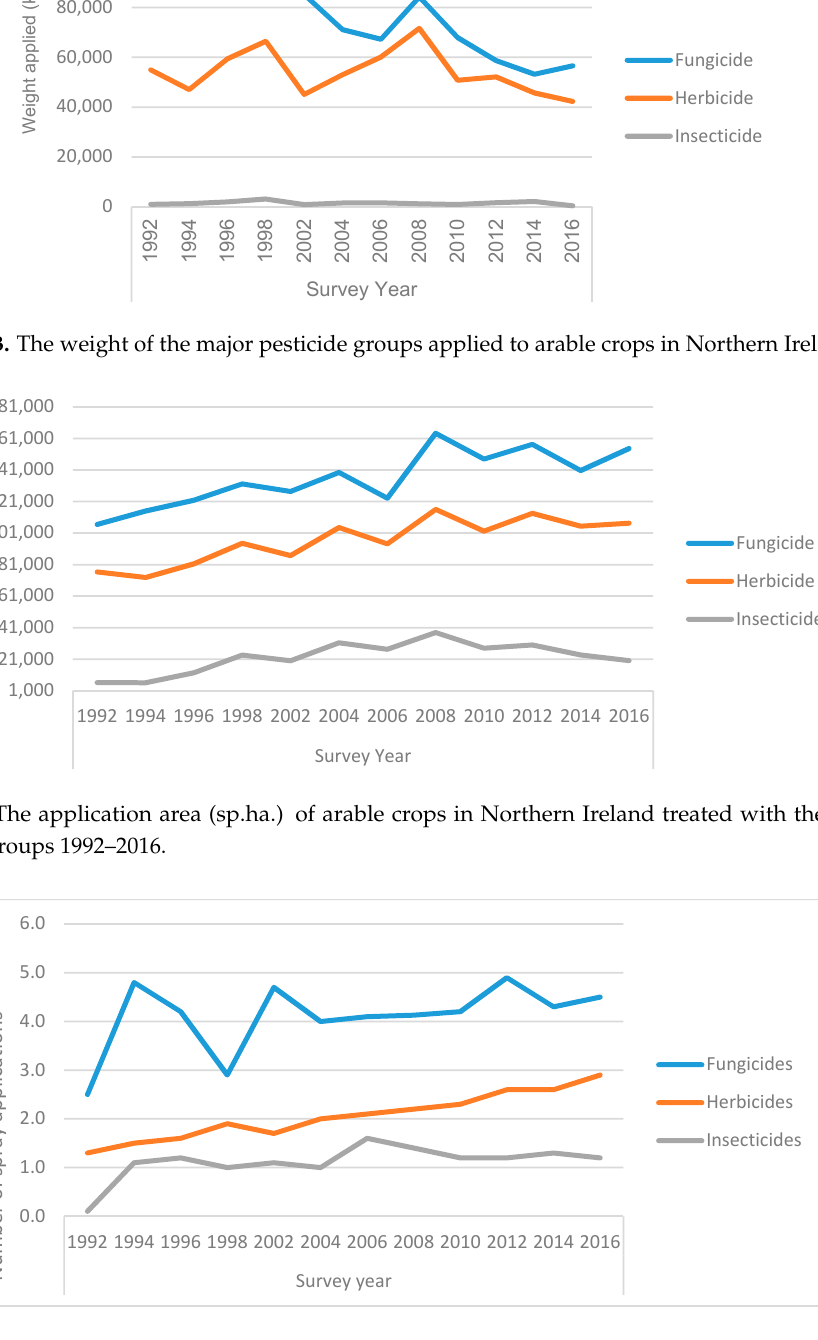
Figure 6. The mean application rate (kg/ha) of the major pesticide groups to arable crops in Northern Ireland 1992–2016.